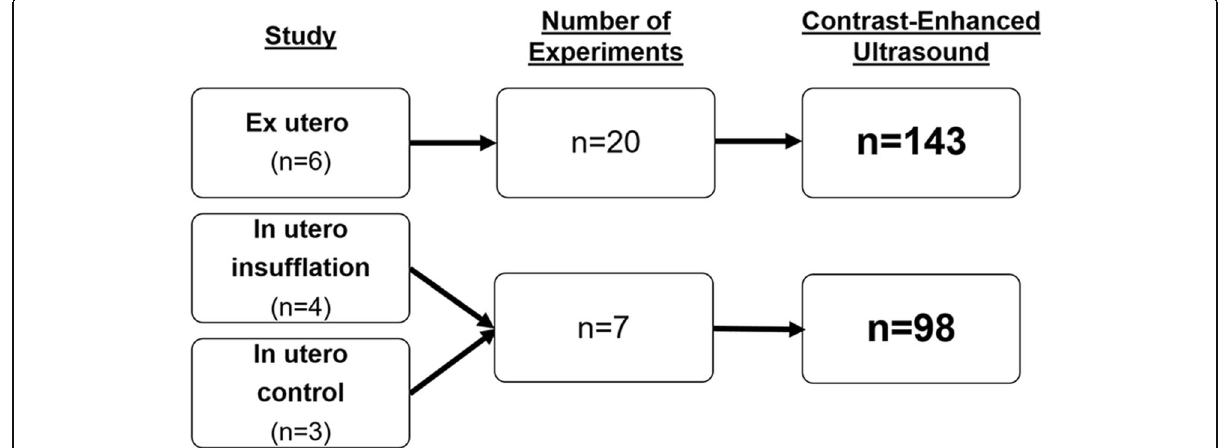
Fig. 4 Flowchart depicting the number of contrast-enhanced ultrasound examinations performed in each study